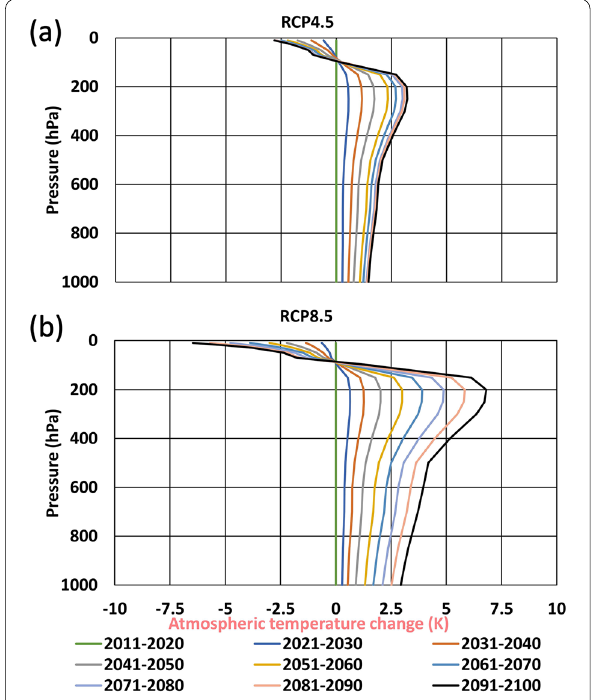
Fig. 10 The difference of averaged T atm in the WNP summer from CMIP5 at a RCP4.5, and b RCP8.5. The difference is calculated by subtracting the 2011–2020 data from the aggregate data of